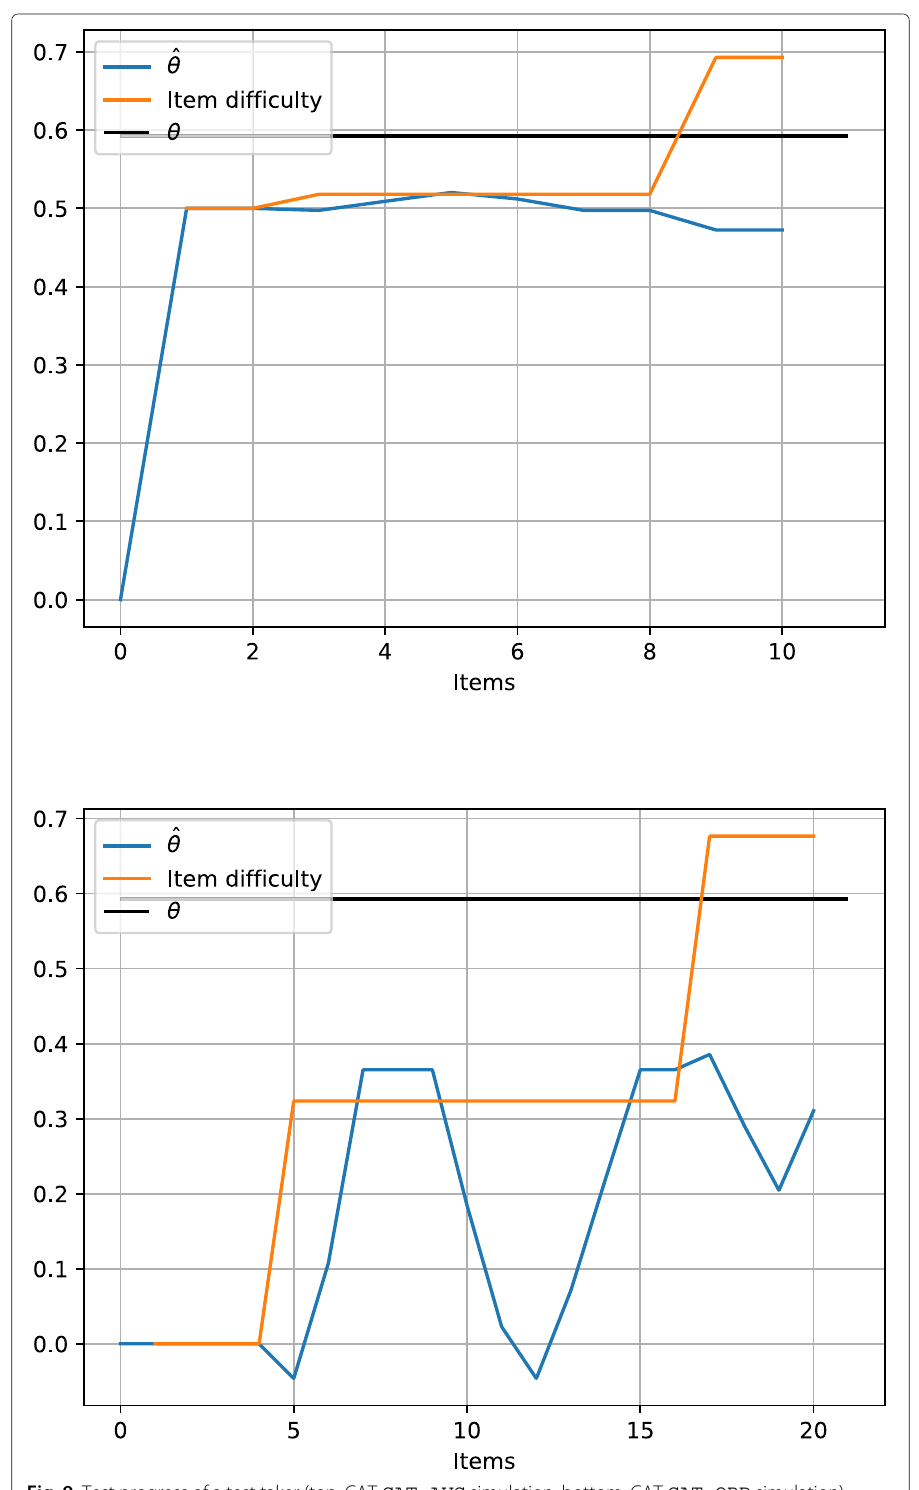
Fig. 9 Test progress of a test taker (top: CAT CAT_AVG simulation; bottom: CAT CAT_ORD